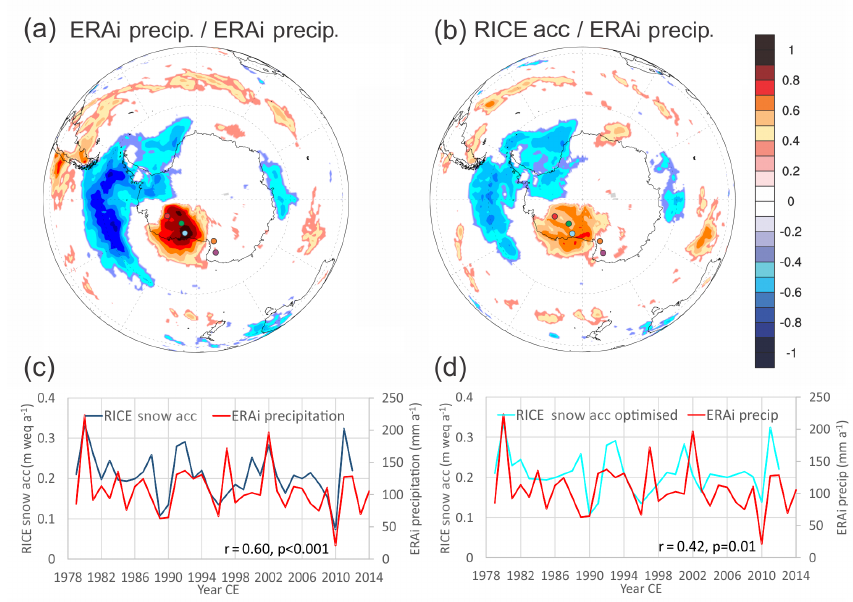
Figure 4. (a) Spatial correlation between ERAi annual precipitation at the RICE site with ERAi annual precipitation in the Antarctic/Southern Ocean region and (b) spatial correlation between ERAi annual precipitation and annually averaged RICE snow accumulation data. Only fields exceeding ≥ 95% significance are shown. The correlation has been performed using http://climatereanalyzer.org/, University of Maine, USA. Comparison of the ERAi precipitation time series with (d) RICE snow accumulation data and (e) RICE snow accumulation with optimised RICE δ D data alignment. Coloured dots indicate locations of WDC (red), Siple Dome (green), RICE (blue), TALDICE and Talos Dome (purple) and Taylor Dome